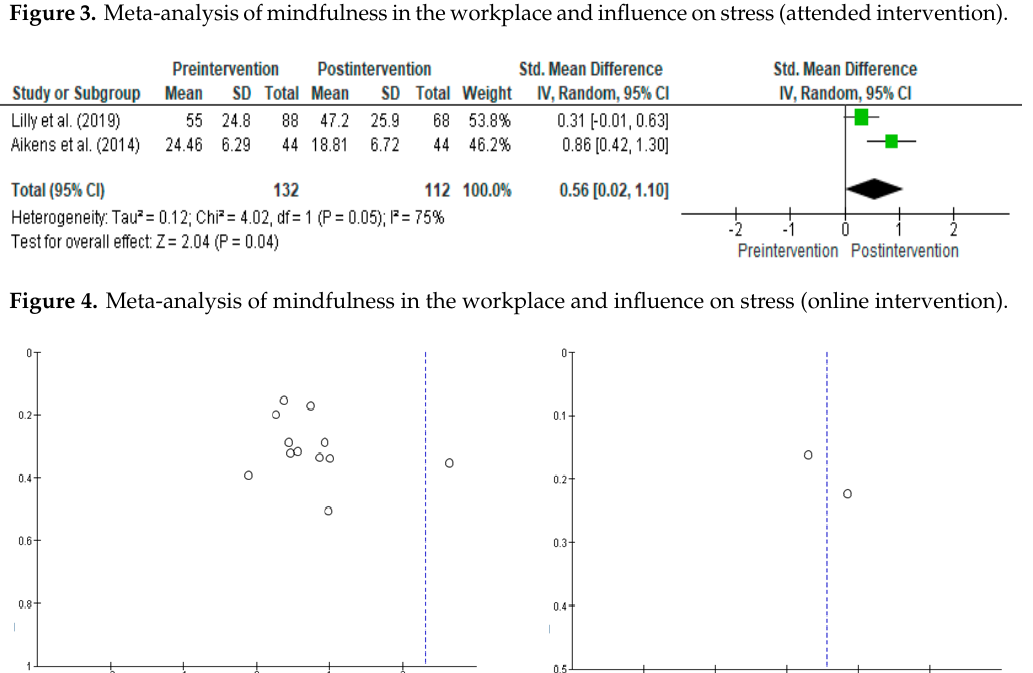
Figure 5. Risk of bias stress (attended intervention – online intervention).